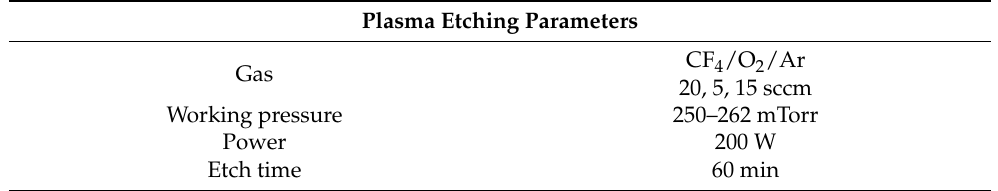
Table 1. Details of the plasma etching parameters.